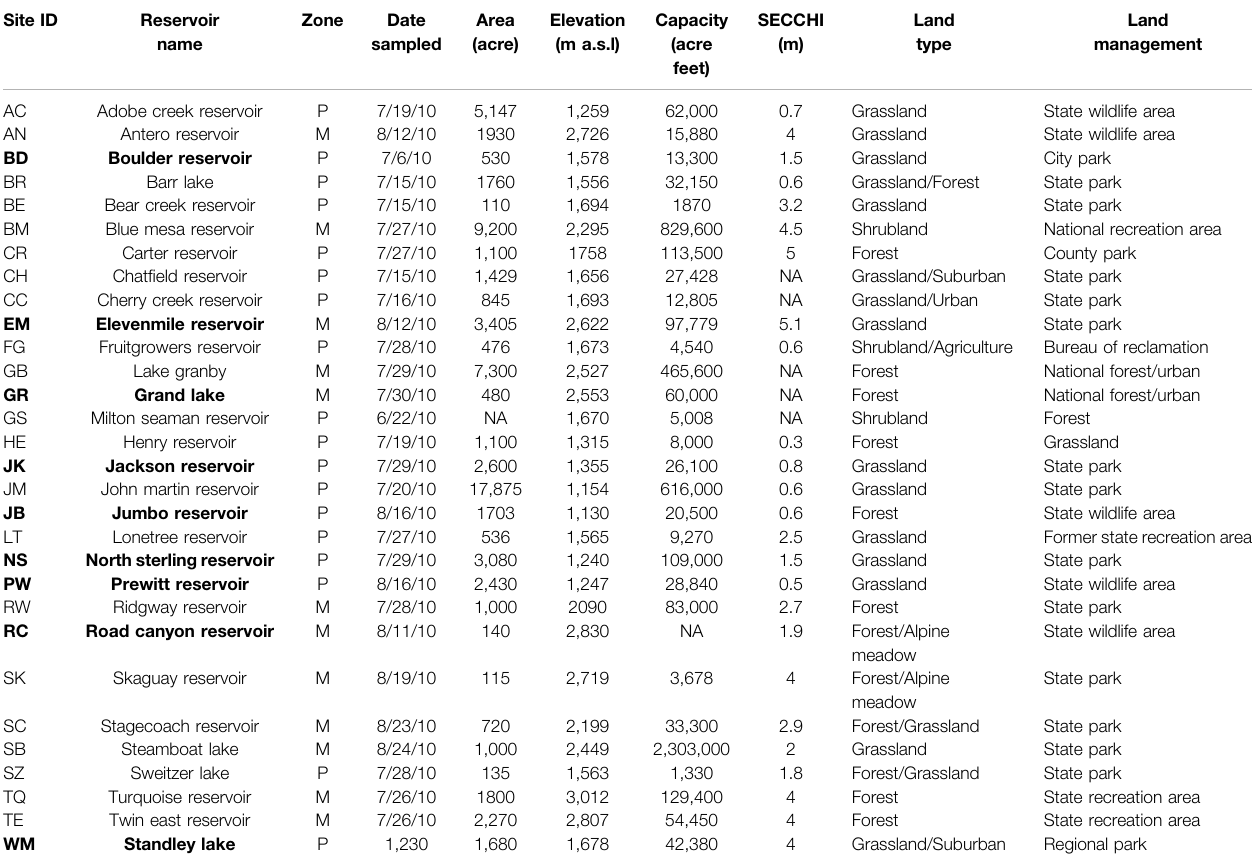
TABLE1| SummaryofphysicalandgeographicalcharacteristicsofColoradoreservoirsstudieddividedintotwozones:Mountain(M)andPlains(P).Theninereservoirswith complete data sets that include all analyses are in bold. Site